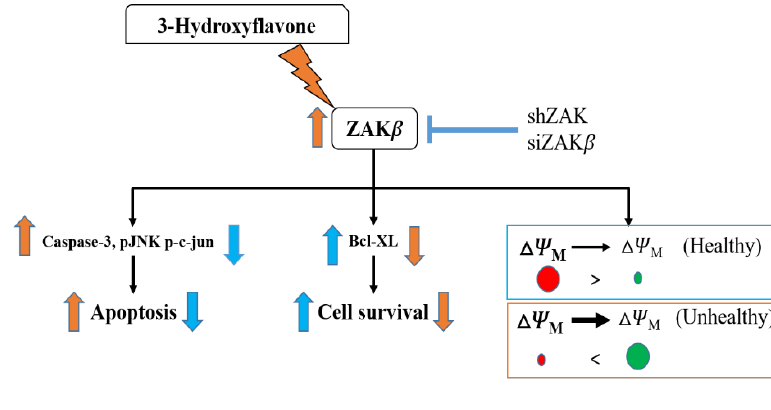
Figure 6. Schematic diagram showing the effect of 3-HF on human OS cells apoptosis. Arrow represents proteins modulated by 3- HF or shZAK and siZAKβ.